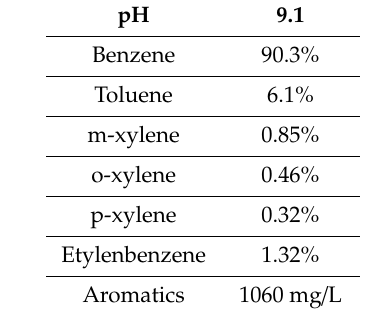
Table 2. Percentage composition and pH of employed industrial waters.